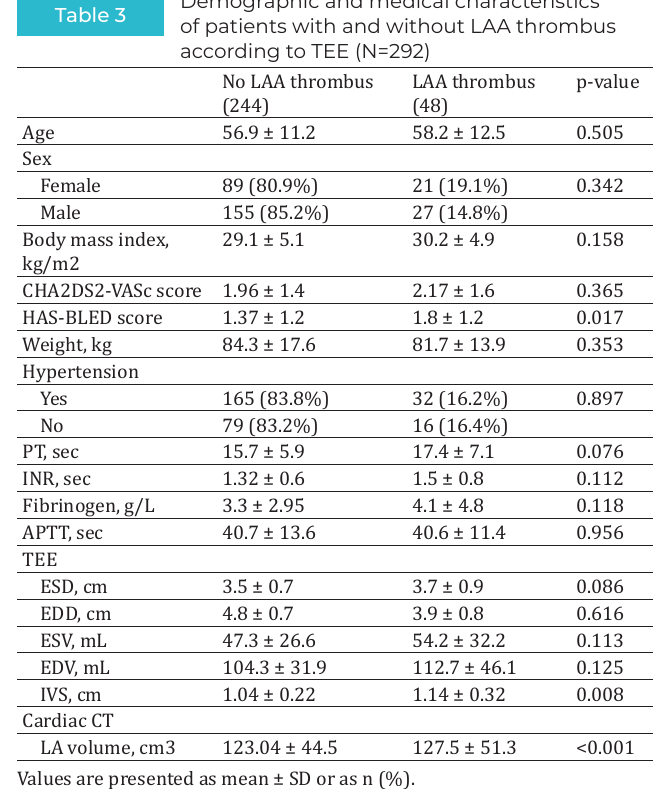
echocardiography Table